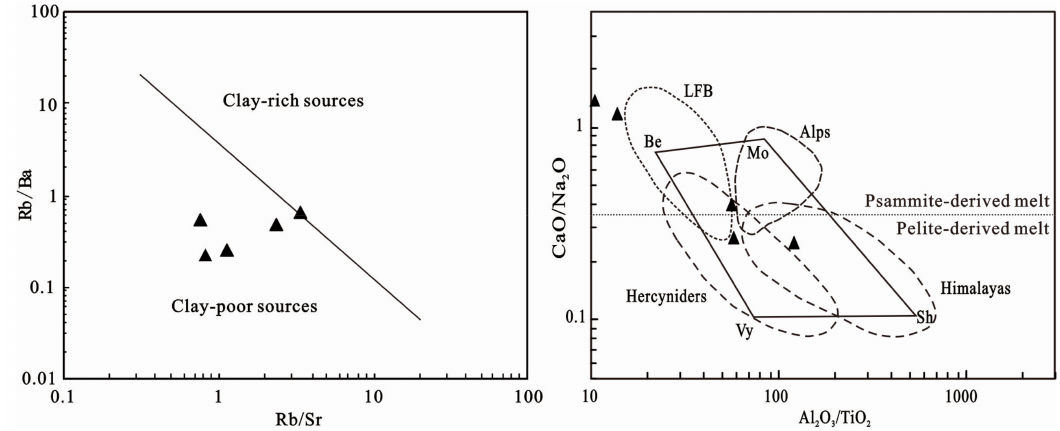
Figure 11. Rb / Ba–Rb / Sr and Al 2 O 3 / TiO 2 –CaO / Na 2 O diagram of the biotite granite (after Sylvester,